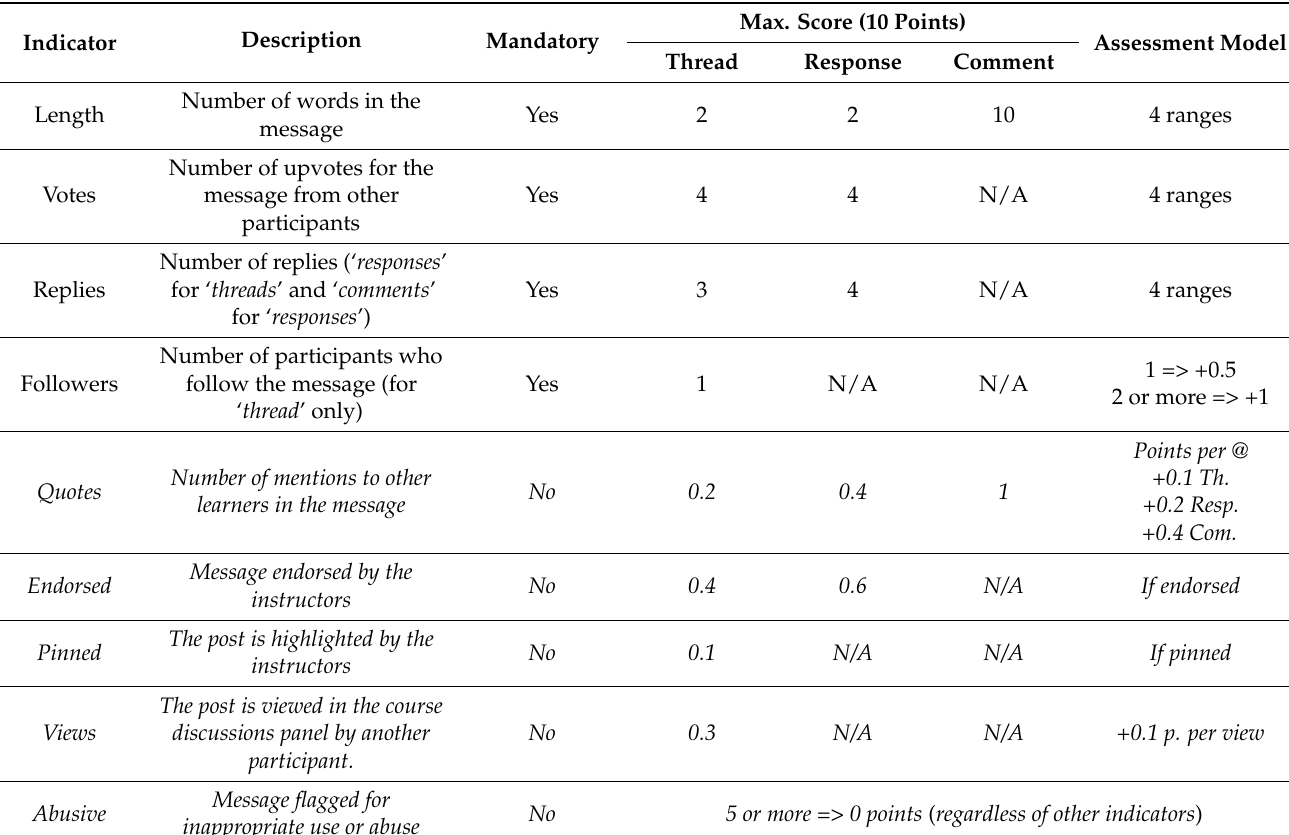
Table 2. Direct quantifiable indicators to assess the relevance of the messages posted by